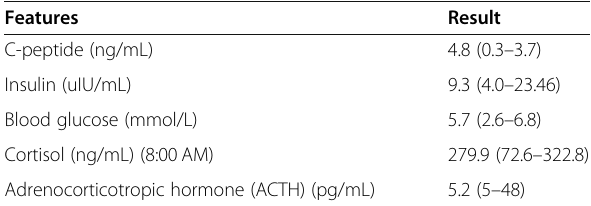
Table 1 Features of hypoglycemia in the patient on the morning of the 9th day after birth